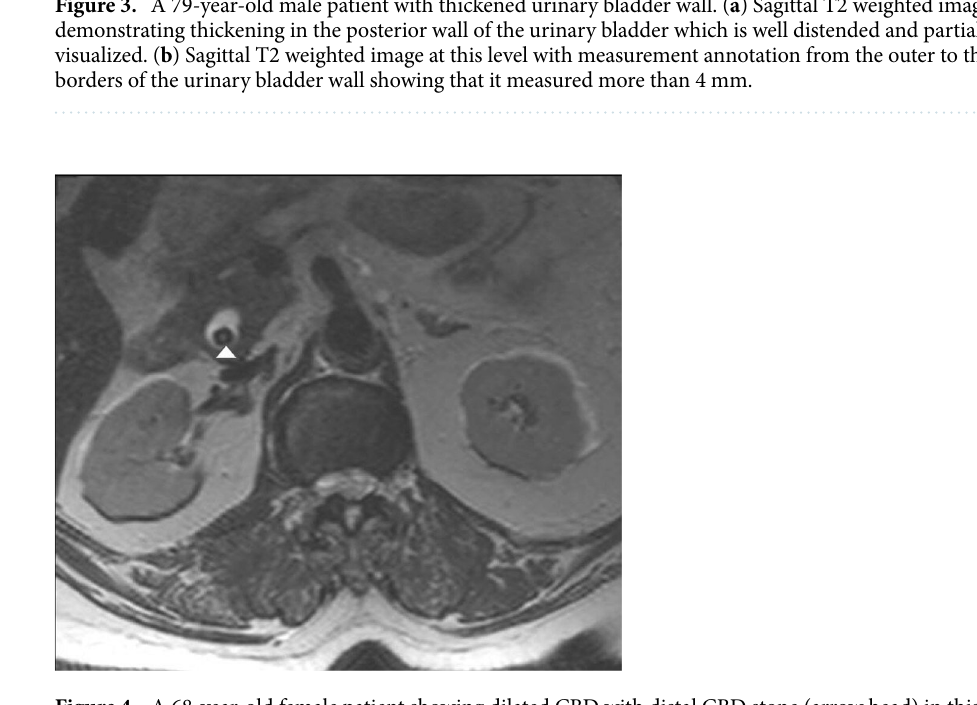
Figure 4. A 68-year-old female patient showing dilated CBD with distal CBD stone (arrow head) in this axial T2 weighted